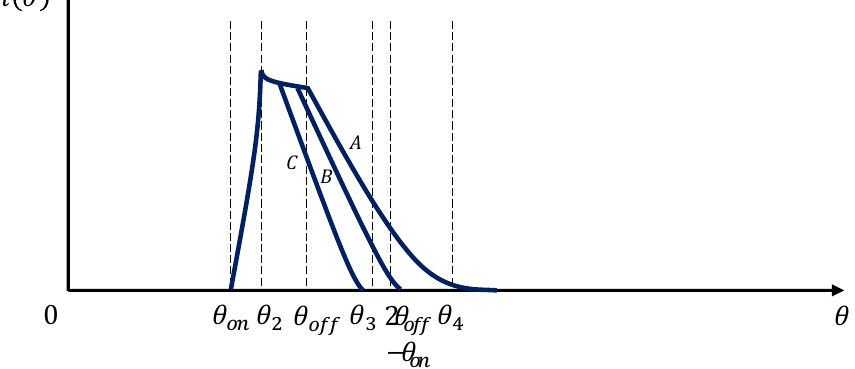
Figure 6. Current curves under constant turn-on angles and different turn-off angles. The curve of the current harmonic components with the turn-off angle can be ob- tained by Fourier transform of the current waveform at different turn-off angles. Figure 7 shows the current harmonic variation rule when the reference current is 5A, the turn-on angle is fixed at 15°, and the turn-off angle varies from 120° to 150°. As can be seen from the figure, as the harmonic order increases, the harmonic amplitude shows a decreasing trend. From the variation trend of current harmonics of each order, it can be seen that the influence of the turn-off angle on current harmonics has obvious regularity. With the in- crease of the harmonic order, the current harmonic amplitude gradually presents the char- acteristics of periodic oscillation with the change of the turn-off angle, and with the in- crease of the harmonic order, the oscillation period gradually shortens. It can be read from the figure that the oscillation period of the 18th order is 20 degrees, and the oscillation periods of the 36th and 48th order of current harmonics are 10 degrees and 5 degrees, respectively. After comparing and analyzing the harmonic amplitudes and their vibration periods of other orders, it is found that the oscillation period of the current harmonic am- plitudes is related to the current harmonic orders, and the following relationship is ap- proximately satisfied between them: